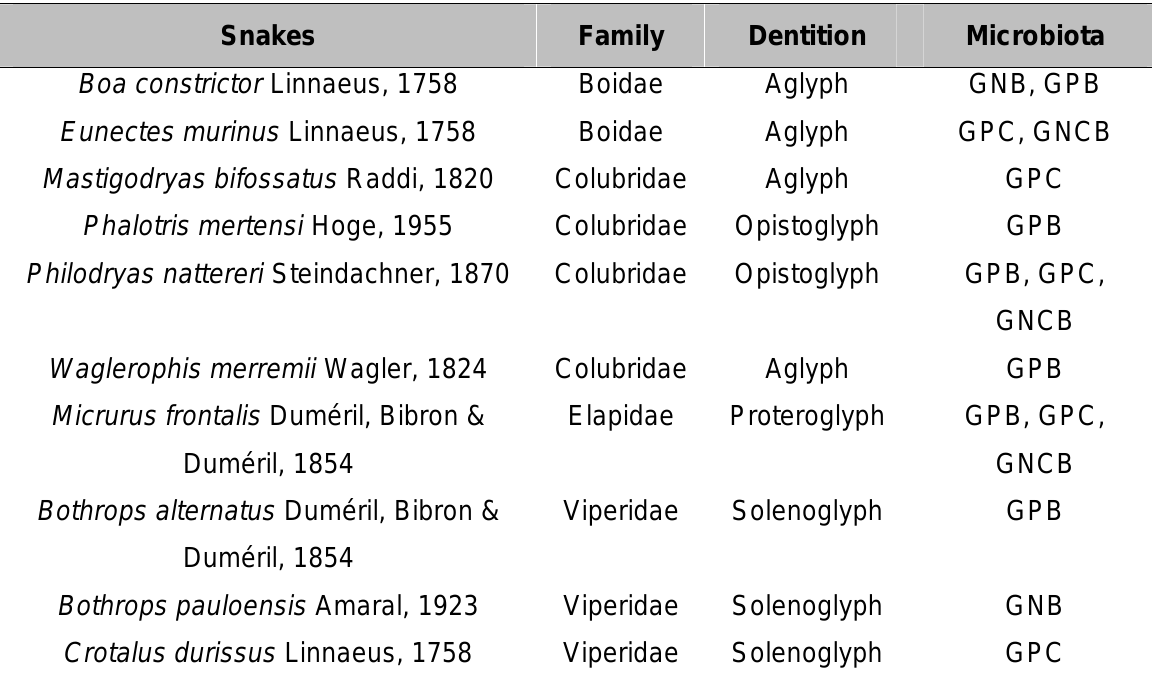
Table 1. Microbiota isolated from oral cavities of studied